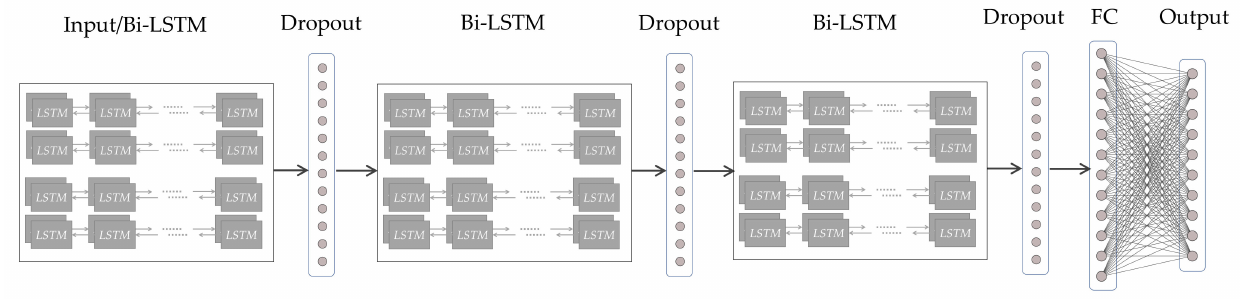
Figure 2. System structure of the iHR estimation model using Bi-LSTM. The original signal as input for Bi-LSTM, and hidden units of LSTM capture temporal dependencies in time series. Dropout layer close to each Bi-LSTM layer to reduce overfitting. To generate HR estimation sequences, three layers of Bi-LSTM and dropout, an FC layer, and an output layer were